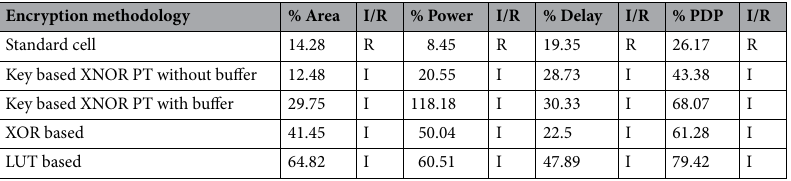
Table 22. % of Changes for XNOR gate.